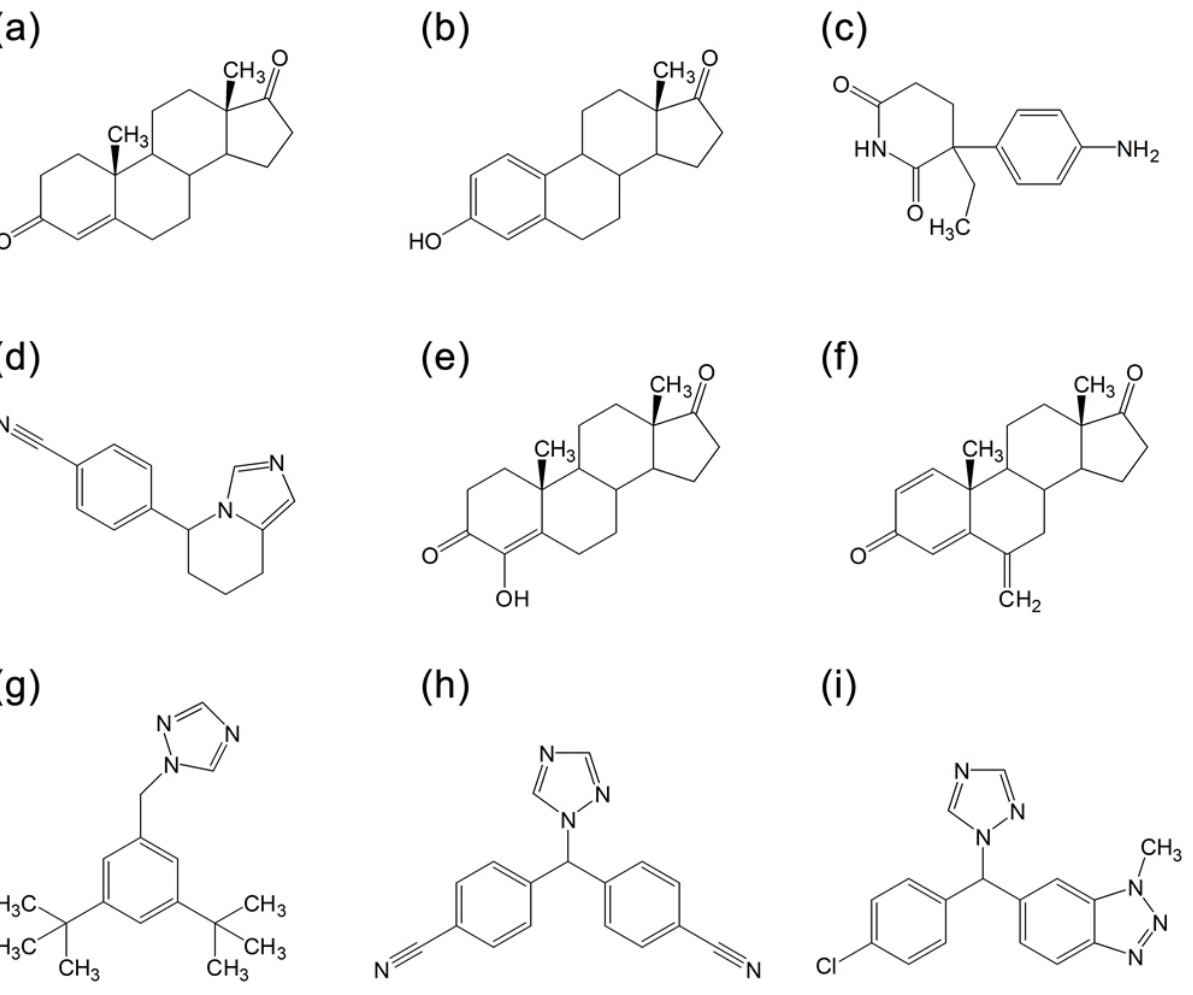
Figure 2. Structures of: (a) androstenedione, (b) estrone, (c) aminoglutethimide, (d) fadrozole, (e) formestane, (f) exemestane, (g) anastrozole, (h) letrozole and (i)